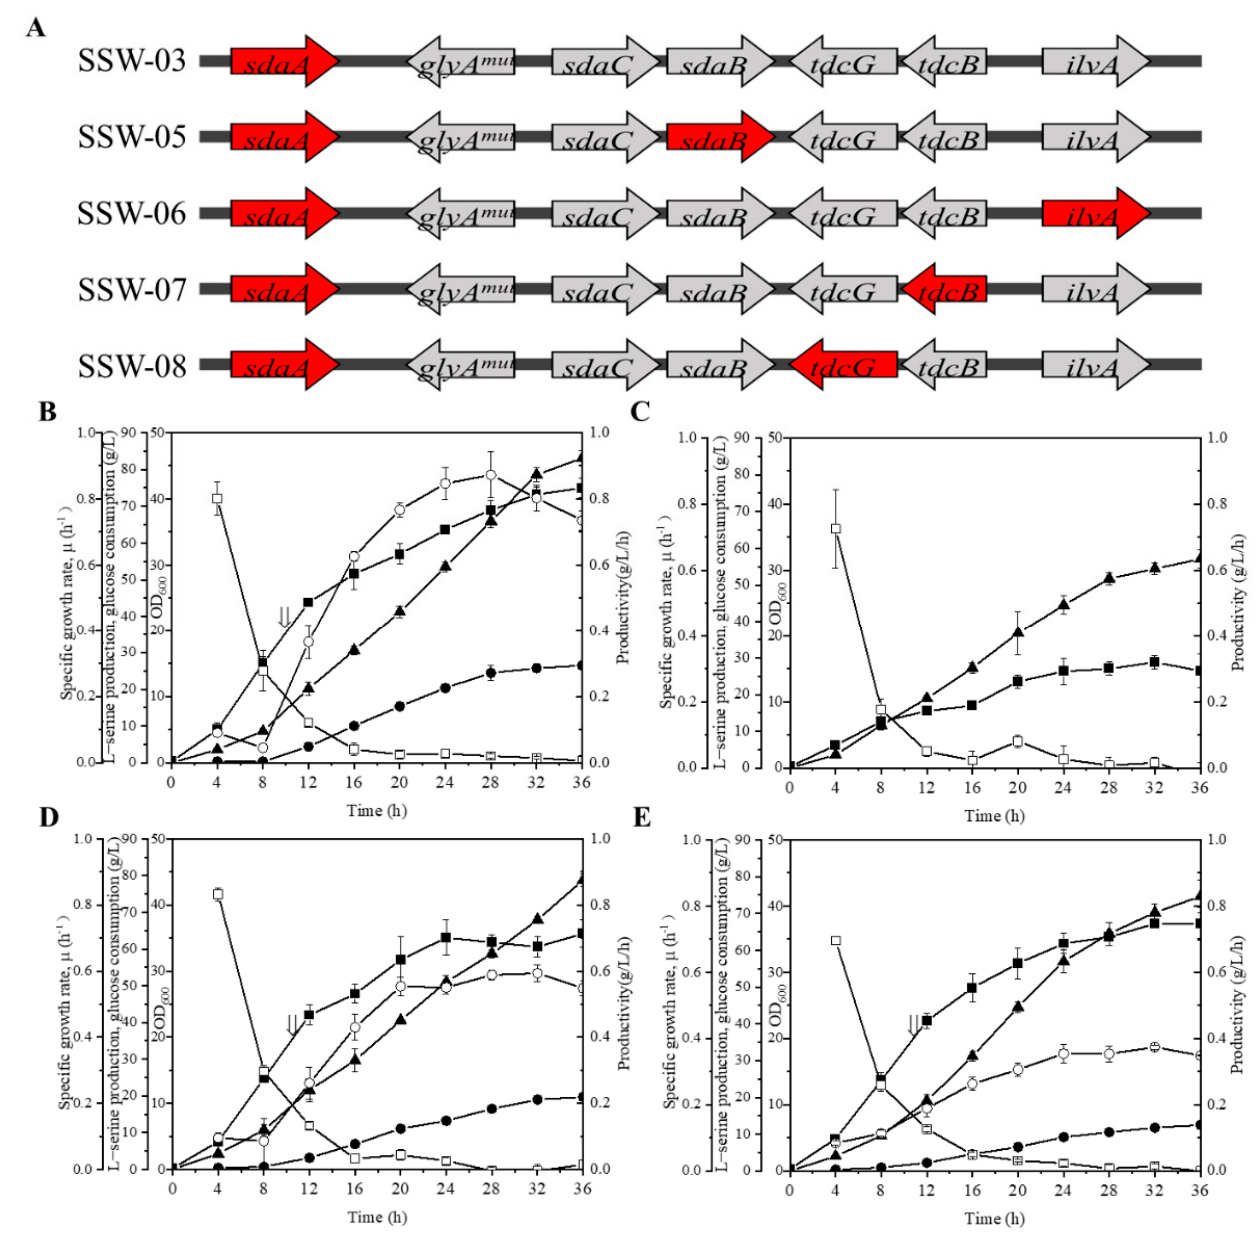
Figure 4. Effect of sdaB , ilvA , tdcB , or tdcG deletion on L-serine production and biomass. ( A ) Geno- types of the strains. The genes marked in red indicate targets for knockout. ( B ) L-serine production by and growth of SSW-05/SP-08 cells. ( C ) Cell density achieved by SSW-06/SP-08. ( D ) L-serine production by and growth of SSW-07/SP-08 cells. ( E ) L-serine production and cell density achieved by SSW-08/SP-08. Cell growth (filled squares), L-serine concentration (filled circles), glucose consump- tion (upward-pointing filled triangles), specific growth rate (open squares), and L-serine productivity (open circles). The arrow indicates the starting point of induction. The data are presented as the means ± SDs from three measurements.